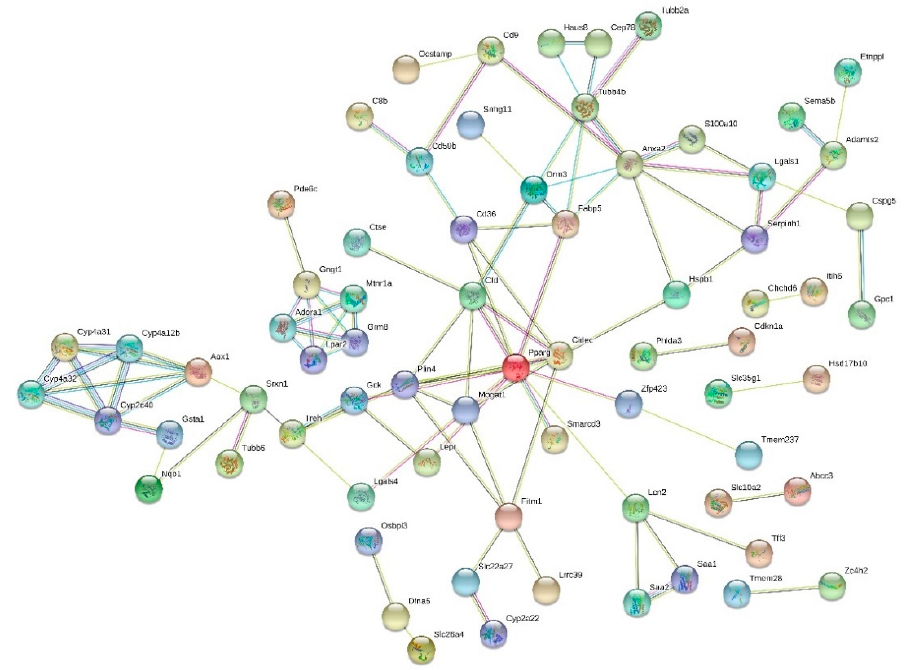
Figure 4. Interactions among the genes with greatest expression fold change in HF vs. LF groups. Genes with expression fold change (FC) > 1.5 or < − 1.5 in high-fat (HF) vs. low-fat (LF) diet groups were studied with STRING. Genes with no identified interactions were excluded from the graph. Colors of the edges: green = activation, blue = binding, black = chemical reaction, red = inhibition, violet = catalysis, pink = posttranslational modification, yellow = transcriptional regulation, grey = other interaction.